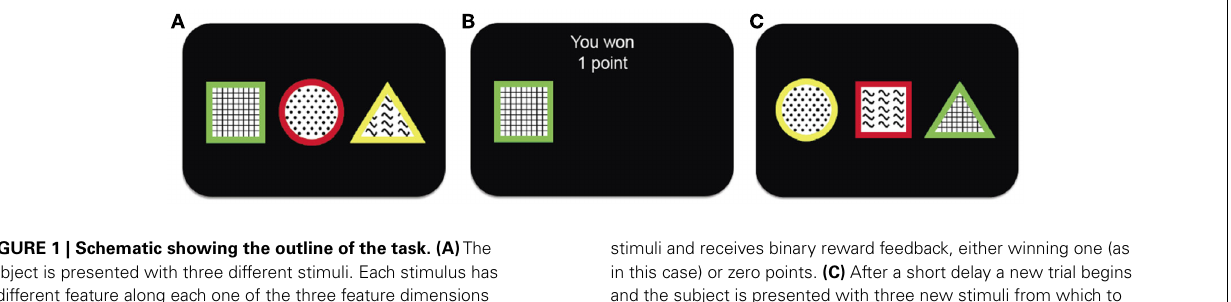
FIGURE 1 | Schematic showing the outline of the task. (A) The subject is presented with three different stimuli. Each stimulus has a different feature along each one of the three feature dimensions (shape, color and texture). (B) The subject chooses one of the